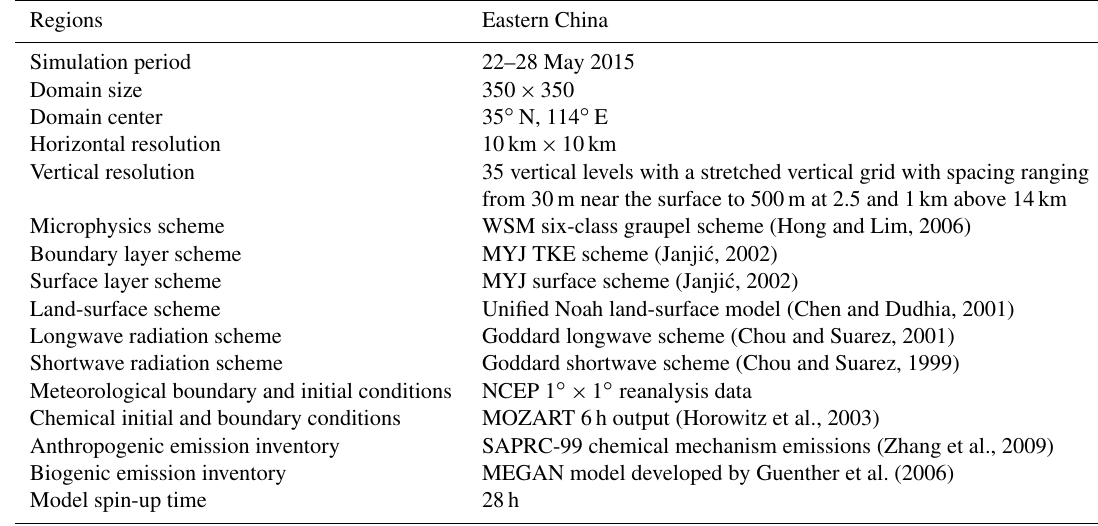
Table 1. WRF-CHEM model configurations. Regions